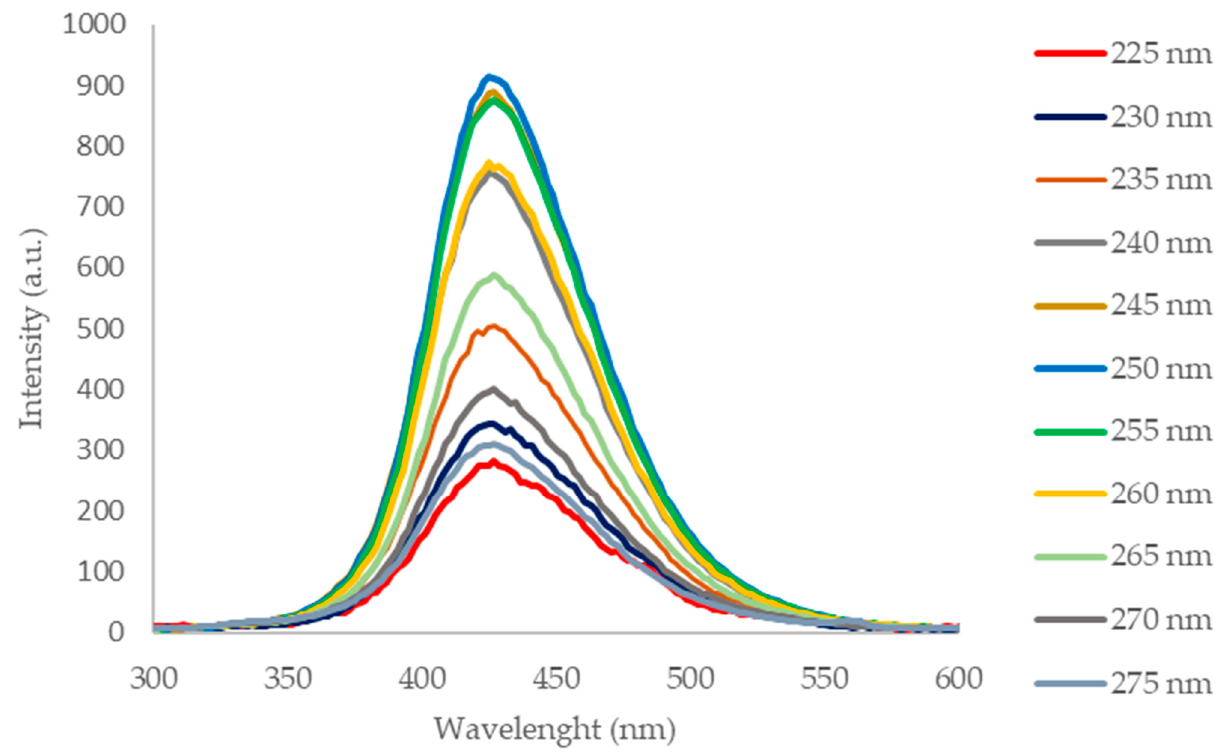
Figure 4. Photoluminescence spectra of CQD-RHA@SiO 2 in the λ ex 225–275 nm range.